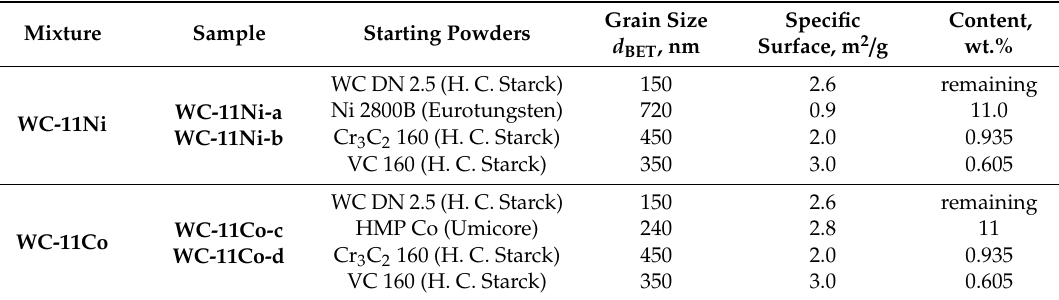
Table 1. Starting powders and sample